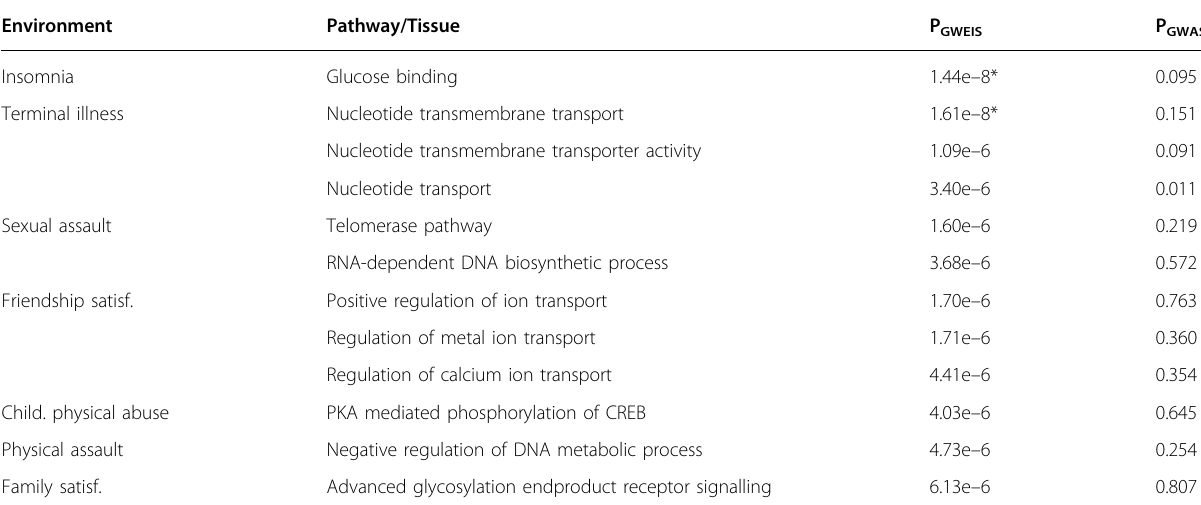
Table 4 Gene-sets detected in the MAGMA gene-set